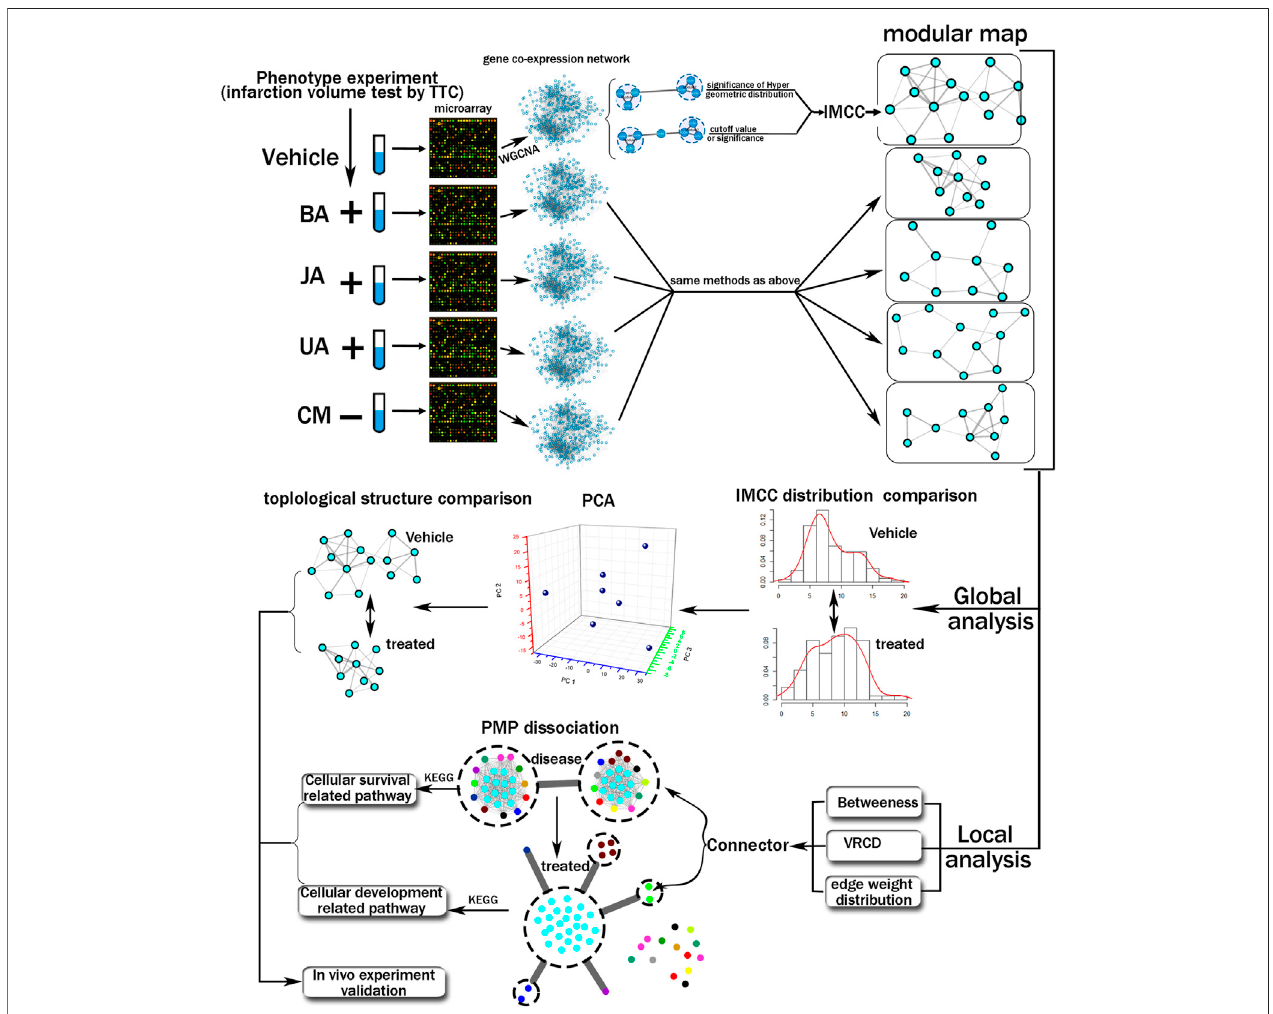
FIGURE 1 | Schematic diagram of the systematic strategies used to reveal variation of global modular map and local inter-module coordination.